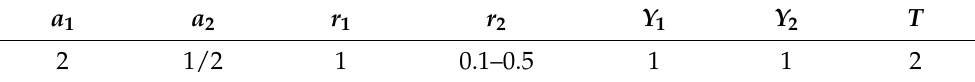
Table 1. Numerical values of the different parameters: case of constant growth rates. a 1 a 2 r 1 r 2 Y 1 Y 2 T 2 1/2 1 0.1–0.5 1 1 2